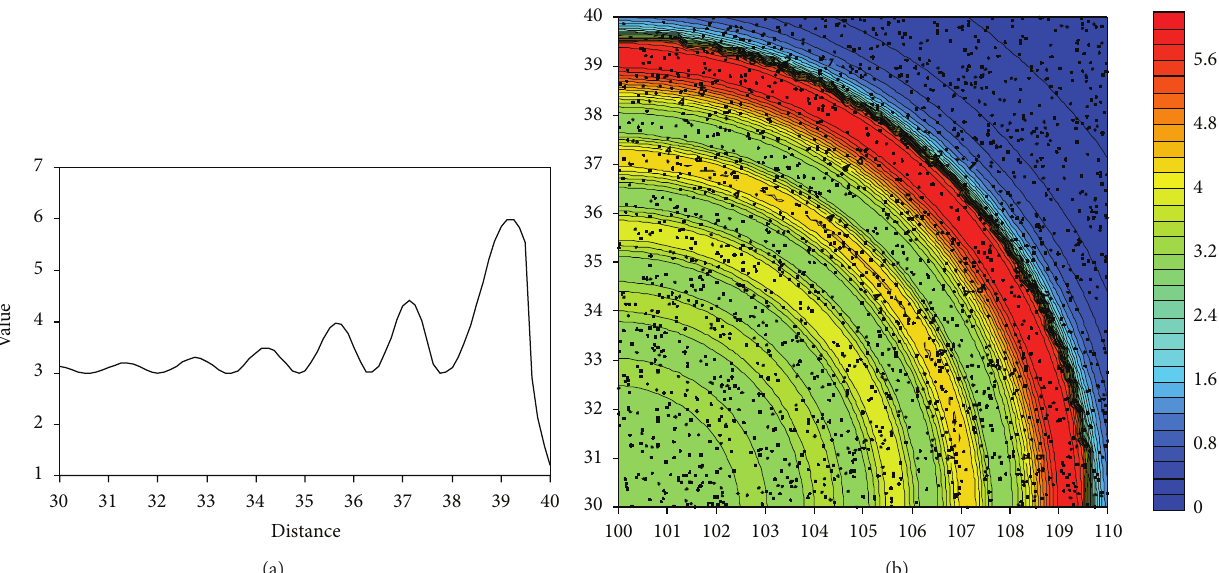
Figure 1: The true temperature field to be analyzed (unit: ∘ C): (a) latitudinal variation along 100 ∘ E and (b) ichnography image. Black dots in the panel (b) show the distribution of 2000 random